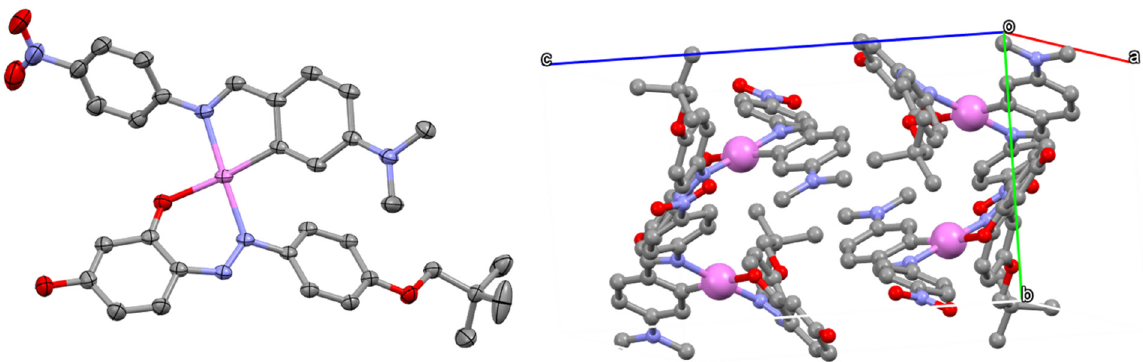
Figure 2. Thermal ellipsoids representation of Pd1 complex drawn at 50% probability (left side). Two different aromatic Schiff bases ligands are coordinated to Pd(II). Atoms are color-coded as follows: palladium (light purple), carbon (grey), oxygen (red), nitrogen (blue). Right side: crystal packing arrangement of Pd1 complex in balls-and-sticks representation showing van der Waals interactions of the dimethylamino benzene group along the b -axis.